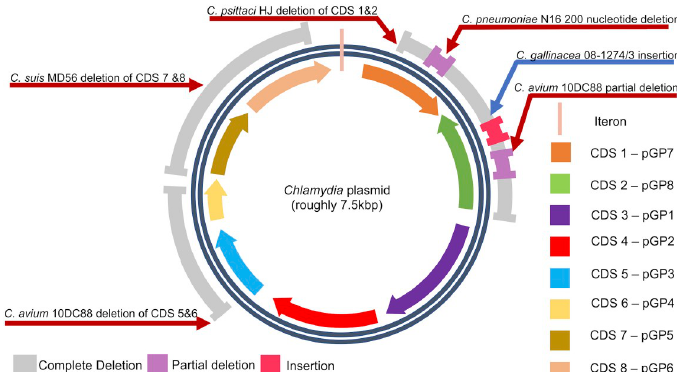
Fig 1. General structure of chlamydial plasmids with annotated mutations and their strain names.